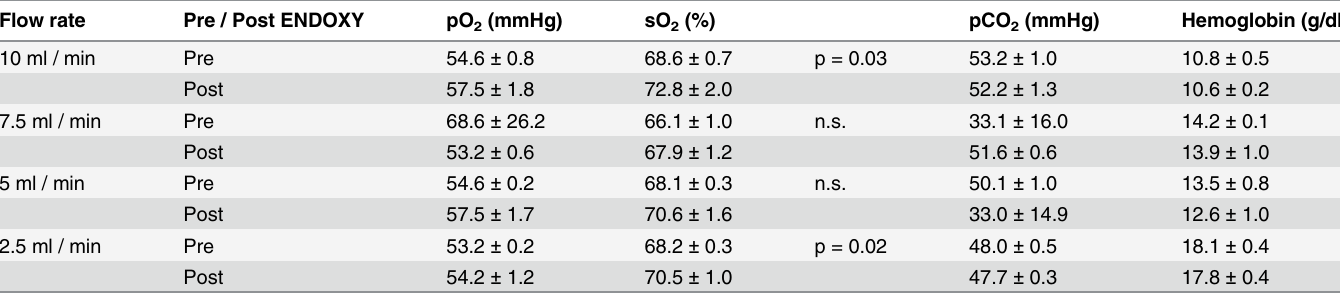
Table 2. Gas transfer measurement of uncoated Lumox ™ slide — blood gas analysis.